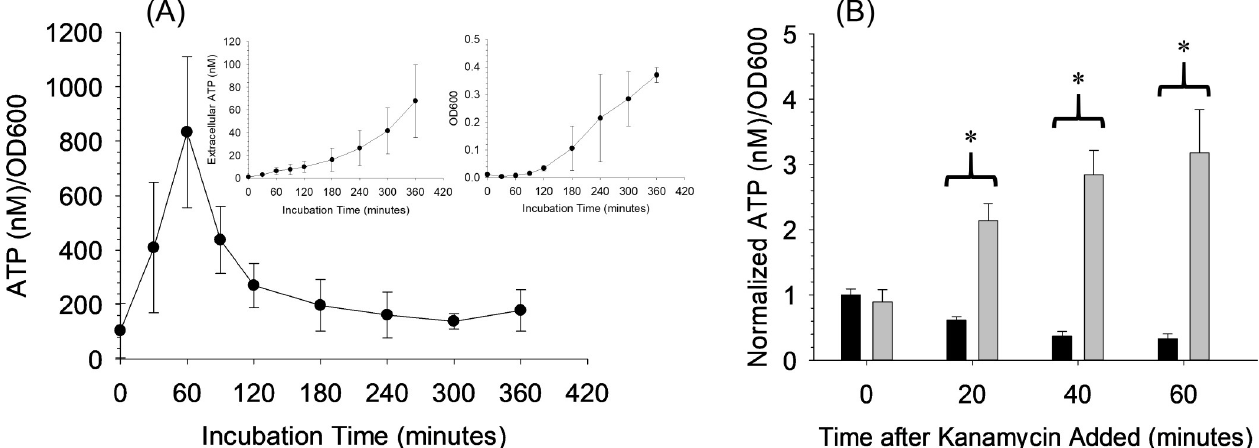
Fig 5. Results for gram-positive B . subtilis . (A) ATP/OD600 curve for gram-positive B . subtilis . Inlayed graphs show the individual extracellular ATP (left inlayed) and OD600 (right inlayed) curves. The OD600 curve does not contain the background absorbance. n � 3; error = standard deviation. (B) Normalized ATP/OD600 graph showing susceptibility of B . subtilis to a bactericidal antibiotic. B . subtilis was preincubated for 2 hours with the antibiotic chloramphenicol (5 mg/L, black bars), which permits selective growth, before adding the antibiotic to which the bacteria are susceptible, kanamycin (gray bars). Kanamycin (50 mg/L), along with the antibiotic that permits selective growth, was compared against a control containing only the antibiotic that permits selective growth. n = 3; error = standard deviation; � p < 0.05.